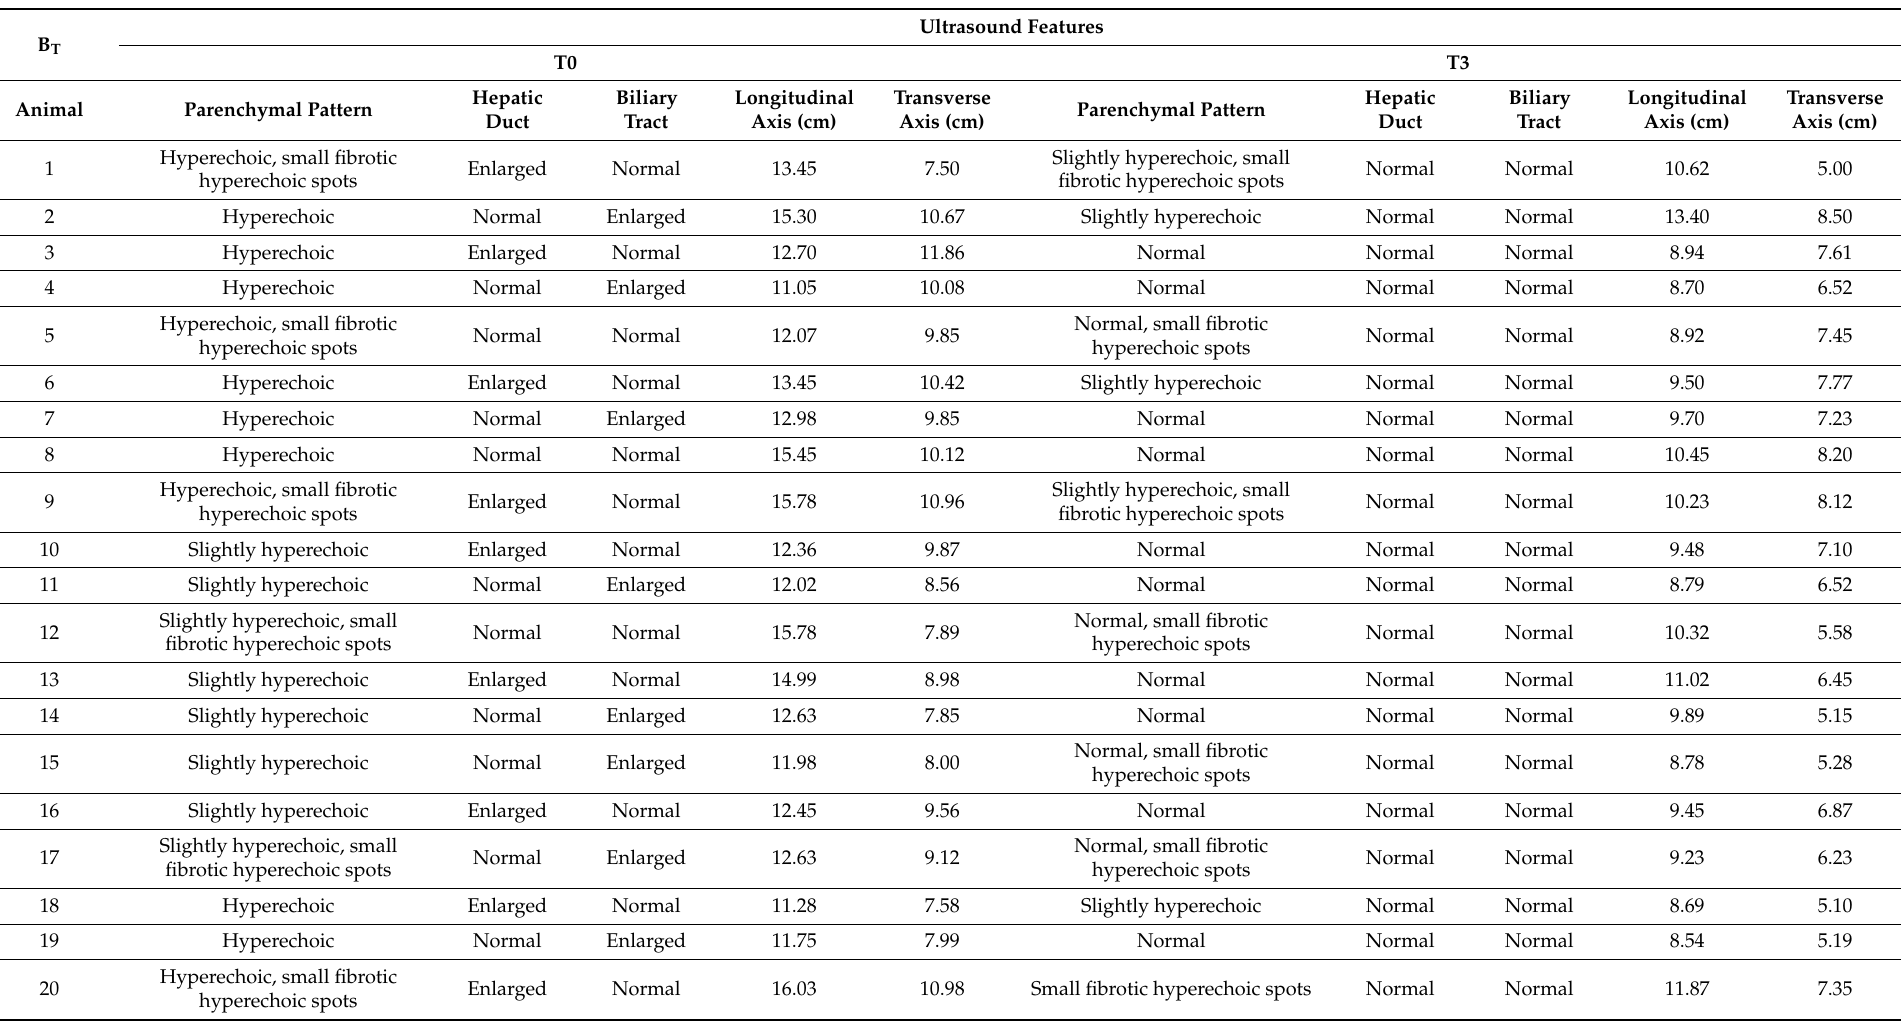
Table 2. Ultrasound features (parenchymal pattern, hepatic duct aspect, biliary tract aspect and liver size recorded on the longitudinal and transverse axis, expressed in cm) observed in each animal of the treated hill dog (B T ) group, at T0 (before the beginning of treatment) and T3 (30 days after the administration of Epacare pet + pasta ®